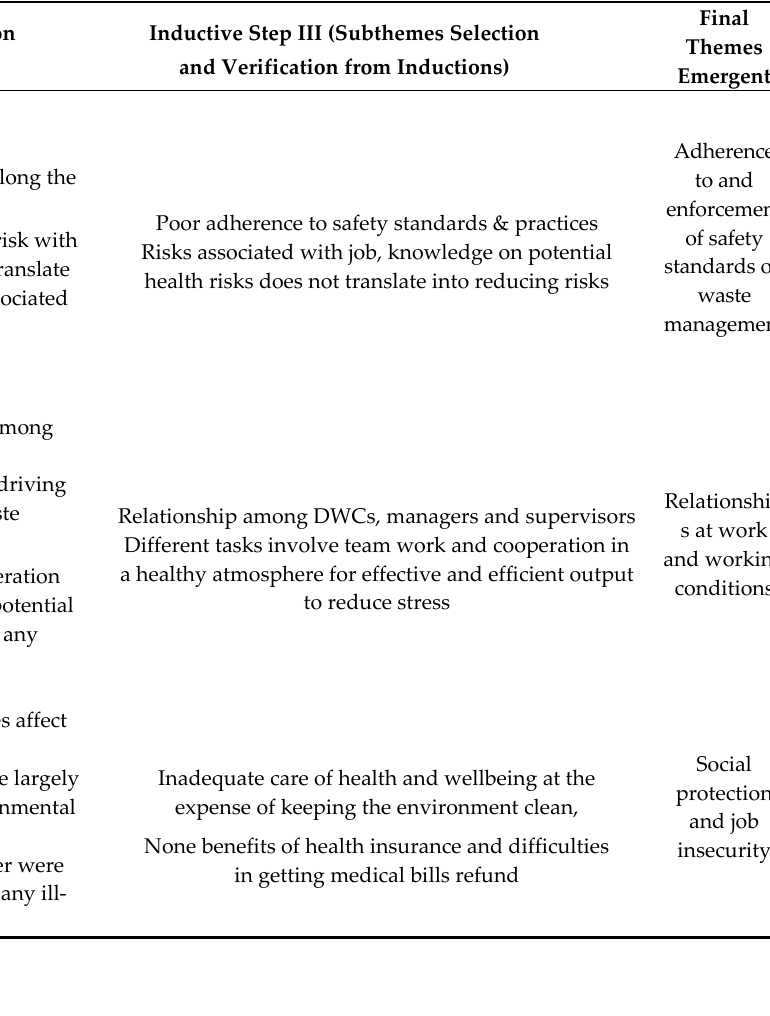
Table 2. Overview of Inductive thematic processes and final themes that emerged among DWC.